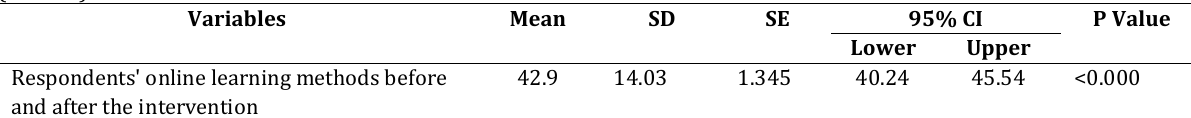
Table 5 .The Effect of G iving the “thinking like a nurse” Simulation Method on Online Clinical Learning Methods